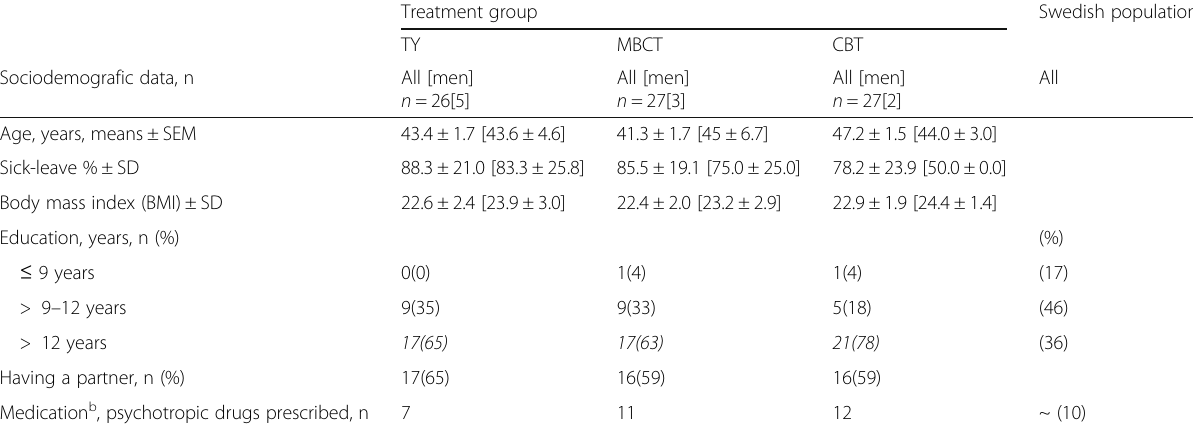
Table 5 Socio-demographic data among the study groups compared to the Swedish population Treatment group Swedish population a TY